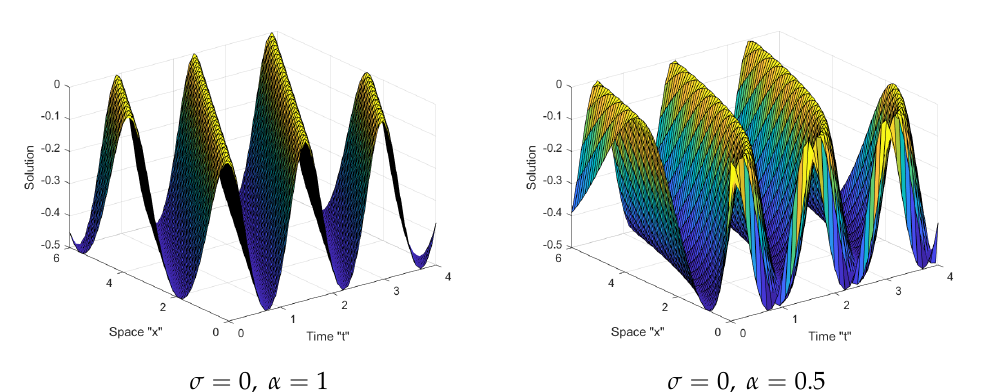
Figure 1. 3D graphs of the solution (31).